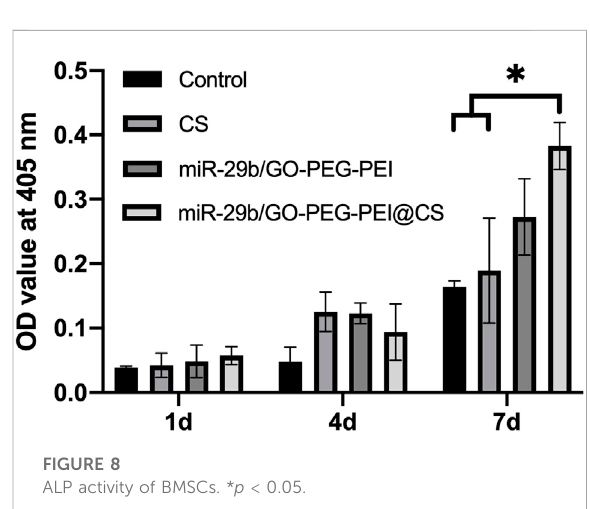
FIGURE 8 ALP activity of BMSCs. * p <